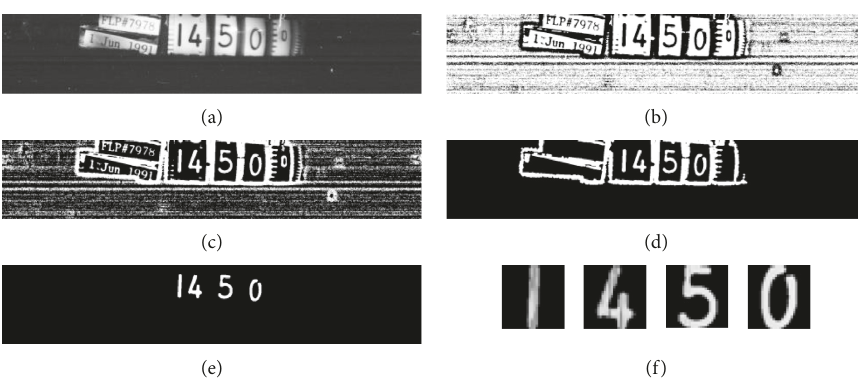
Figure 5: Algorithm flow